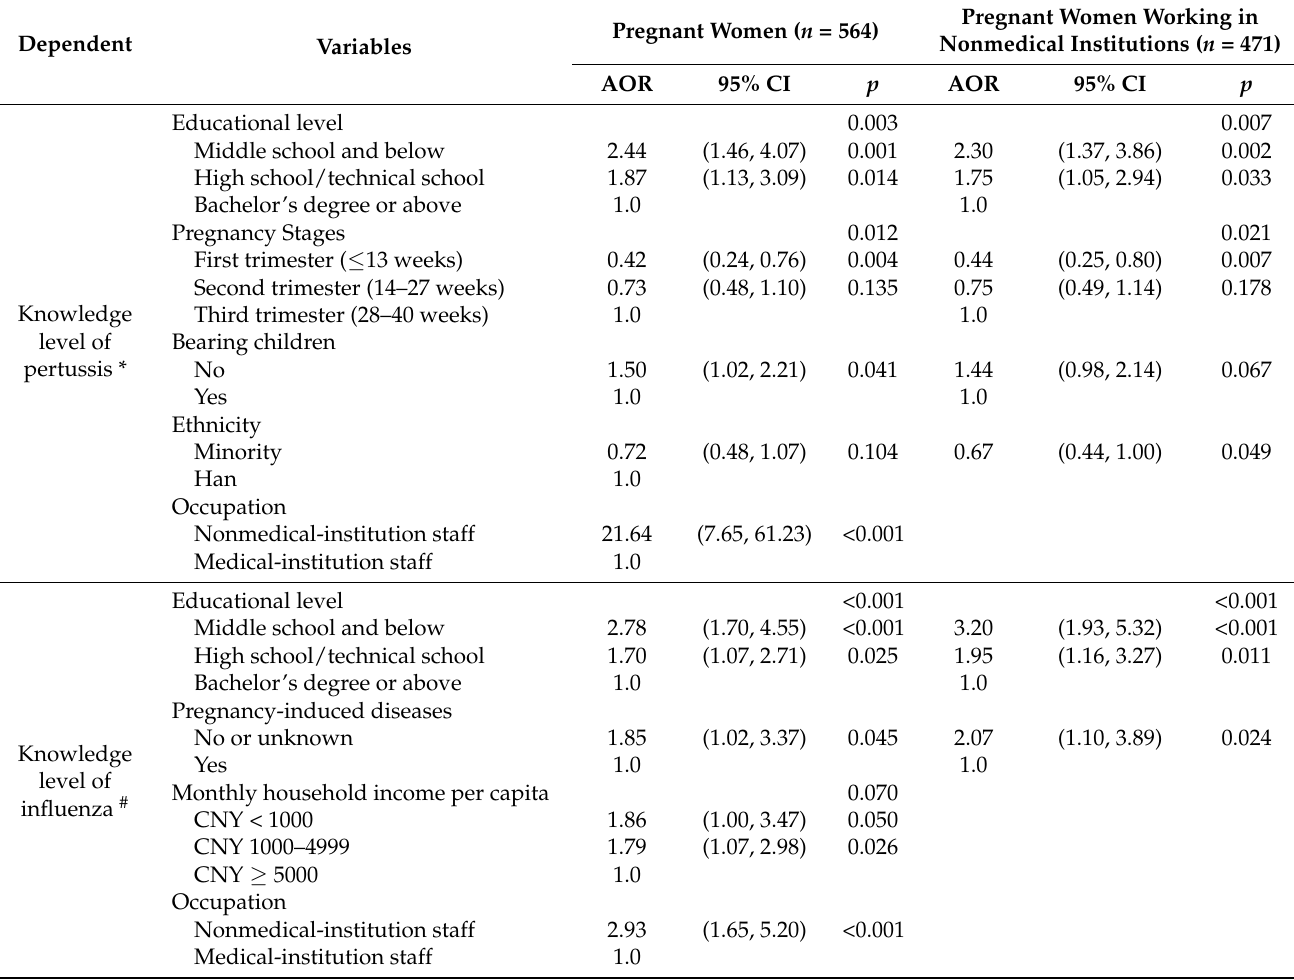
Table 6. Multivariate analysis of epidemiological knowledge levels of pertussis and influenza among pregnant